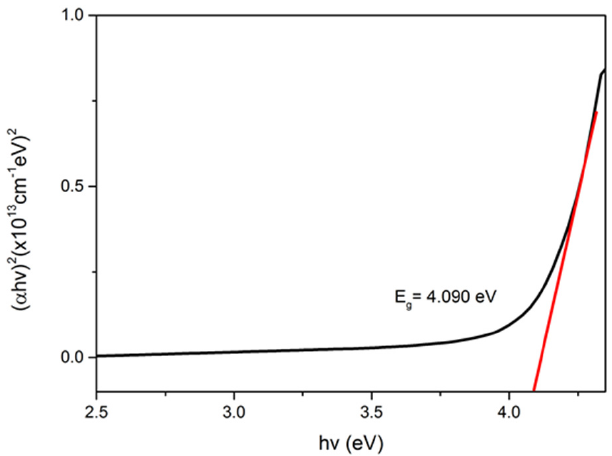
Figure 5. Optical band gap of GO thin film.